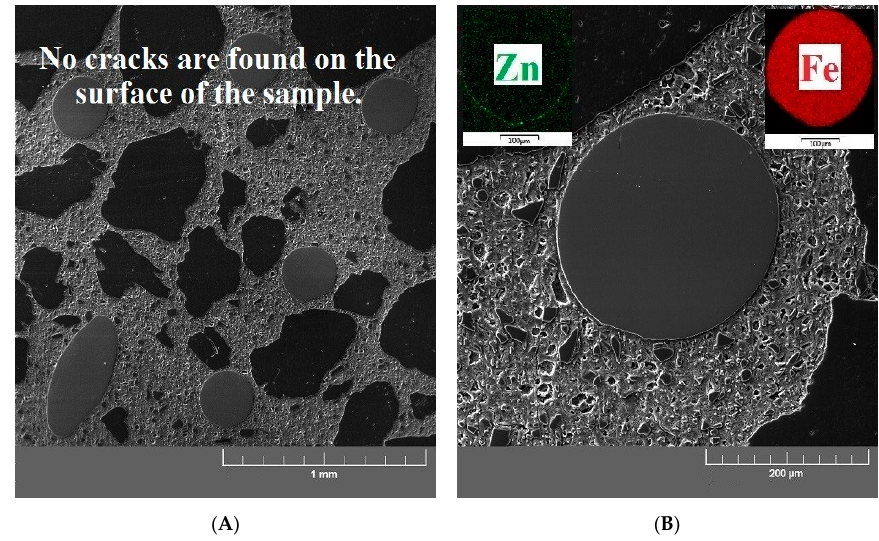
Figure 15. ( A ) SEM image of the reference sample focused on the UHPC matrix/aggregate interfacial transition zone. ( B ) SEM image of the reference sample focused on the brass-coated steel fiber/UHPC matrix interfacial transition zone.